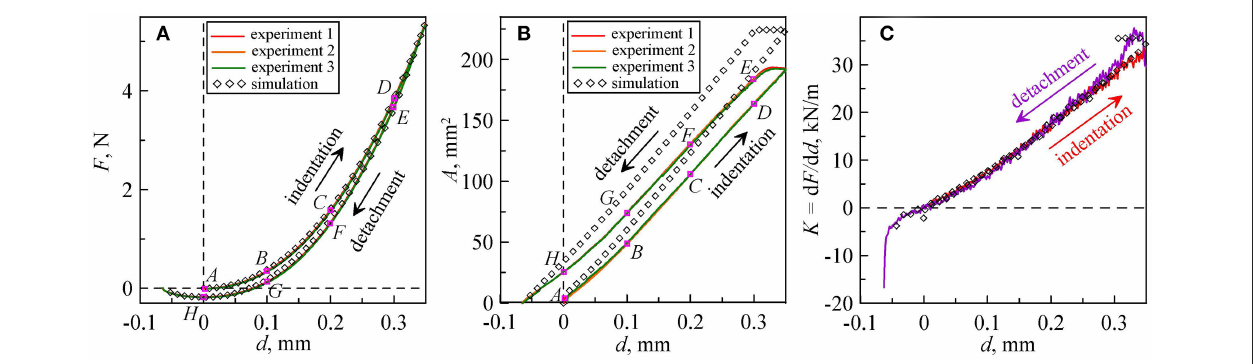
FIGURE 2 | Dependencies of (A) normal force, (B) contact area, and (C) contact stiffness on indentation depth in a contact between a steel ball with radius of R = 100mm and a rubber sheet with thickness h = 5mm. Solid lines are experimental results for three consecutive loading cycles; symbols are results of numerical simulations. Panel (C) shows dependence of contact stiffness only for the first indentation